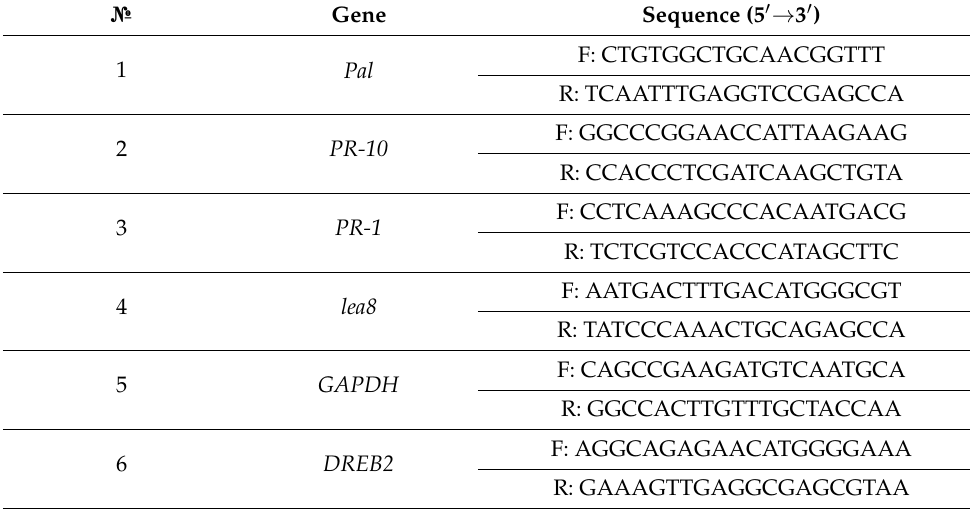
Table 1. Primer sequences for stress resistance